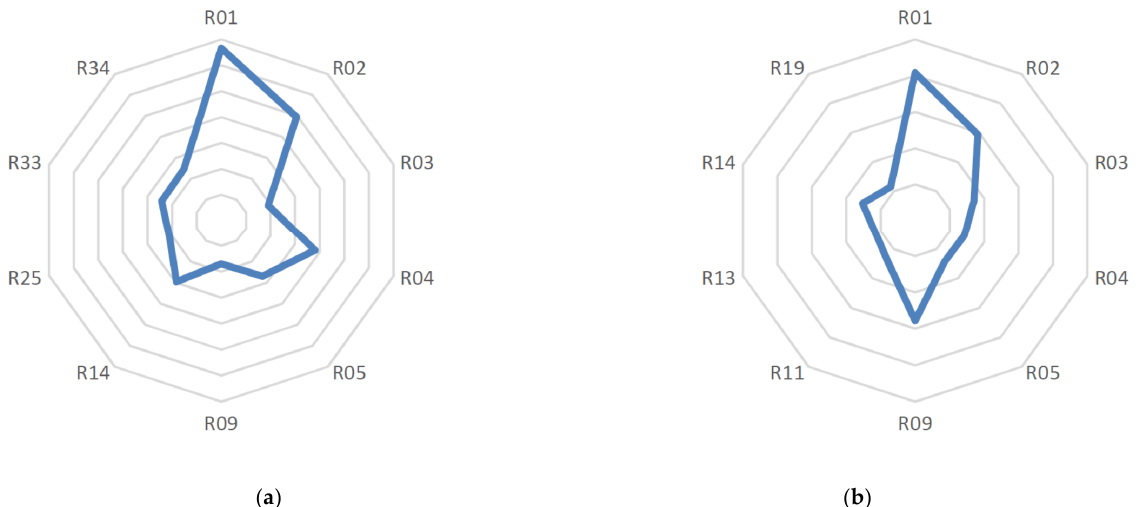
Figure 6. ( a ) Top 10 risks for environment objective, ( b ) Top 10 risks for for safety objective.